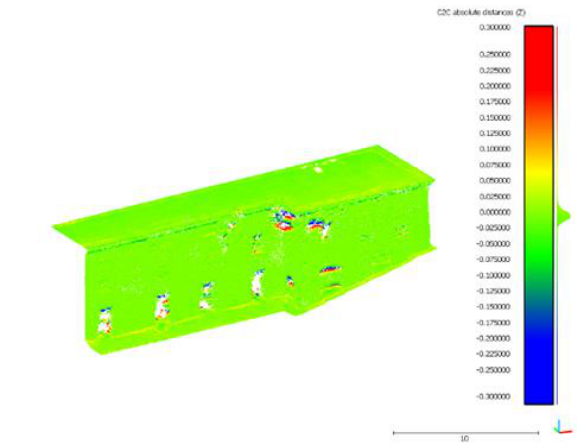
Figure 4 . Distances along the z axis resulting from the Cloud- to-Cloud application after registration the two point clouds by setting shift and rotation in the three directions x,y,z.